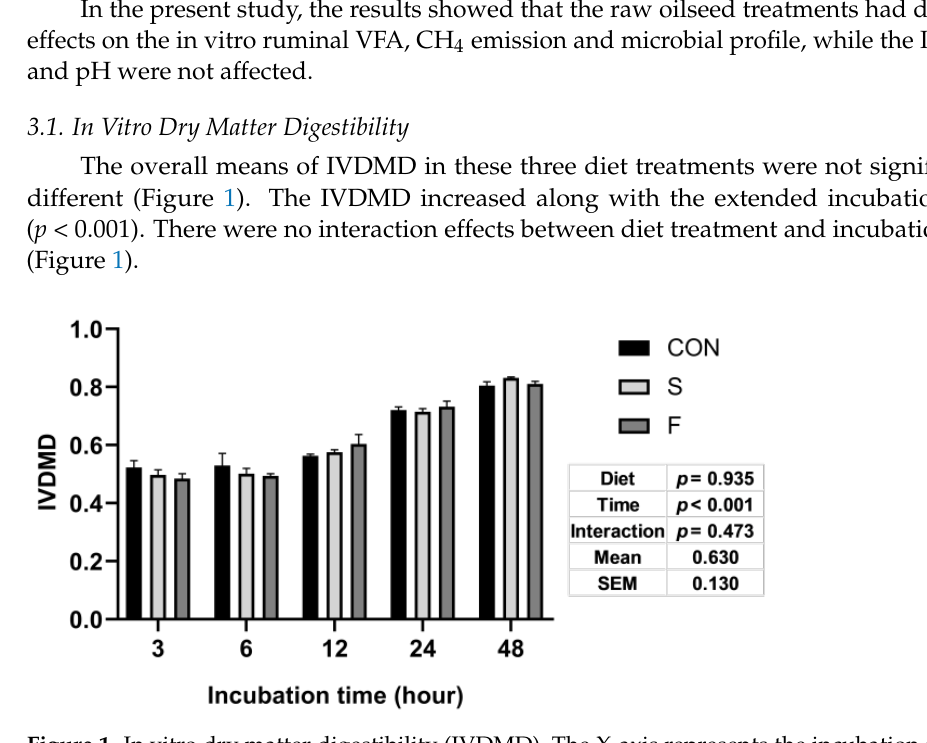
Figure 1. In vitro dry matter digestibility (IVDMD). The X-axis represents the incubation time (h). Y-axis represents the IVDMD value. CON: Control group, S: Raw whole soybean treatment, F: Raw flaxseed treatment. Diet: Diet treatment effects, Time: Incubation time effects, Interaction: The interaction effects between diet treatment and incubation time. Data are shown as the mean ± SEM, n = 6.